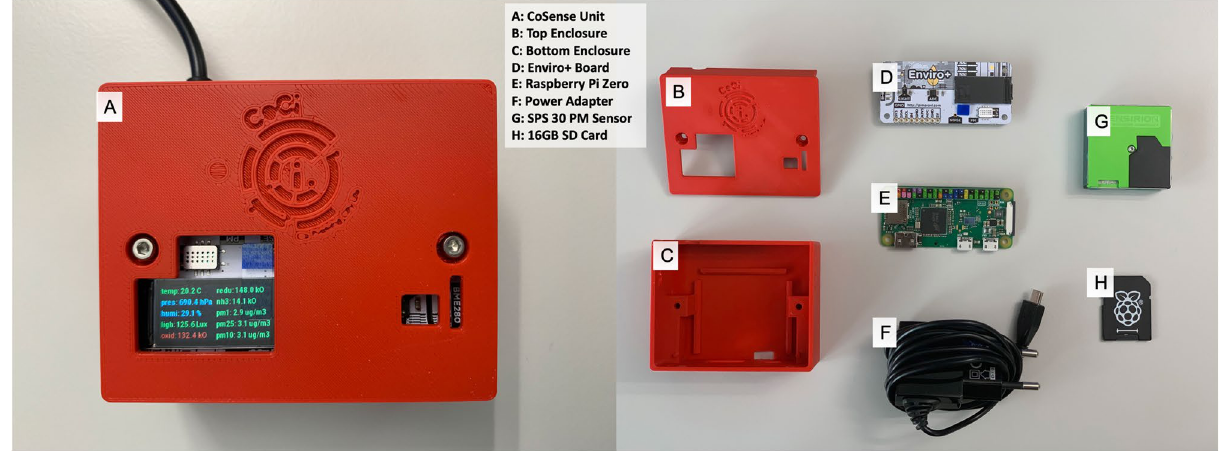
Figure 4. A complete and exploded view of the CoSense Unit with